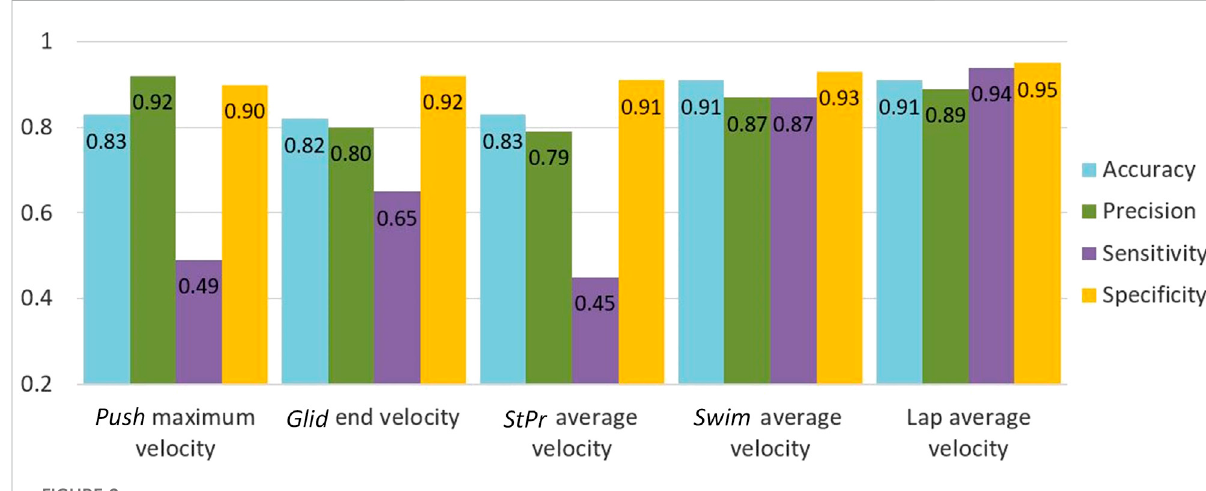
FIGURE 2 Accuracy, precision, sensitivity and speci fi city of goal metrics for detecting a meaningful progress (lap time change).